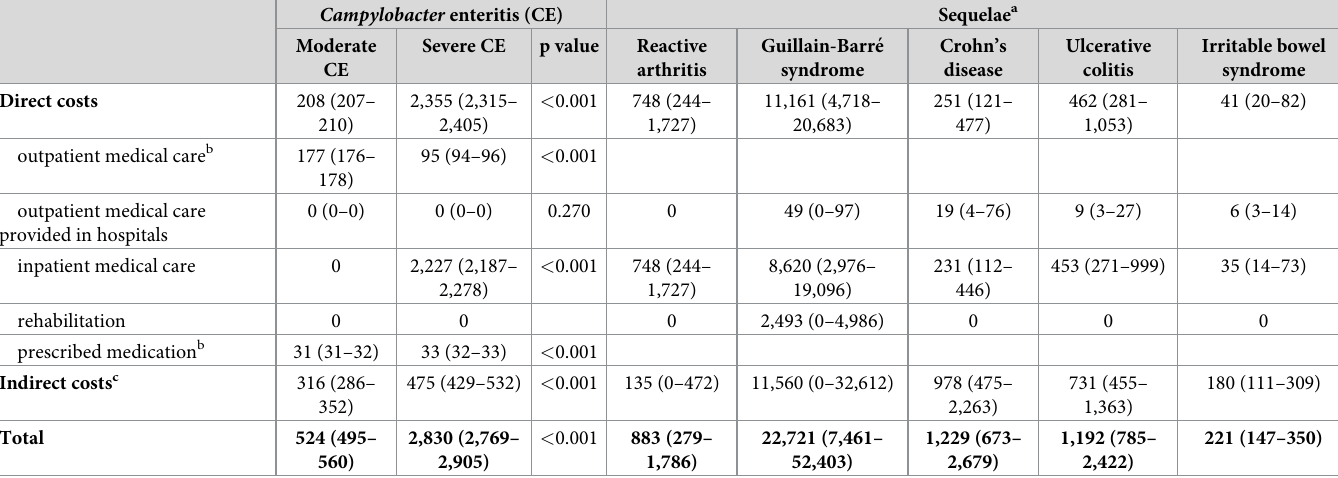
Table 3. Mean disease-related costs per patient over a 12-month period [in € (95% confidence